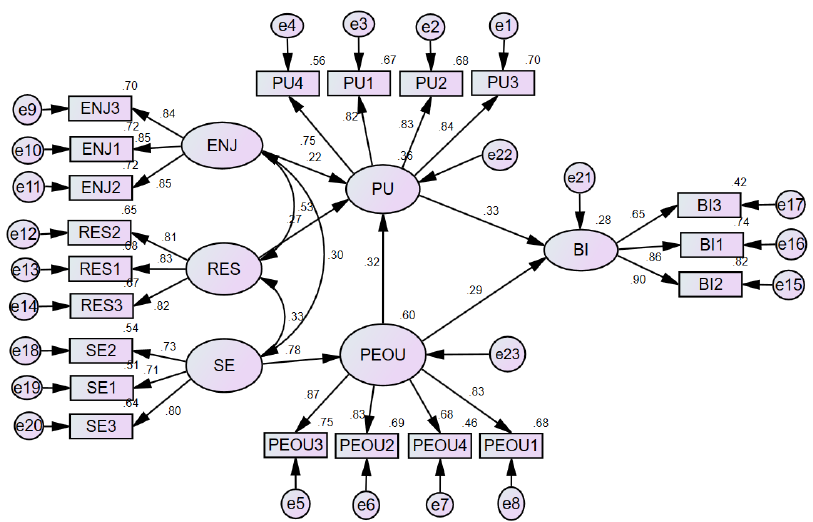
Fig. 2. Structural Model with Parameter